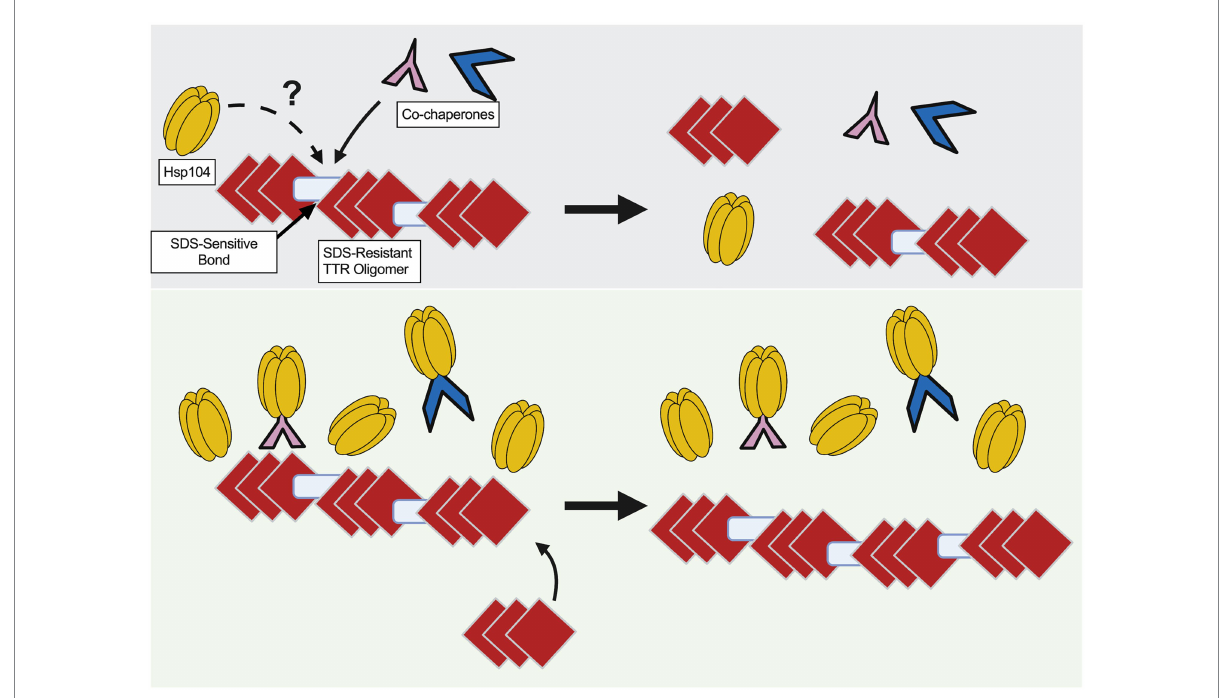
FIGURE 6 Model of TTR aggregate growth by excess Hsp104. Red diamonds represent SDS-resistant TTR oligomers and blue rectangles represent SDS- sensitive associations to depict large TTR aggregates. (Top) Co-chaperones, possibly along with Hsp104, play a role in maintaining smaller sized aggregates. (Bottom) Excess Hsp104, or Hsp104 A503S , increases aggregate size by possibly titrating chaperones away from the TTR